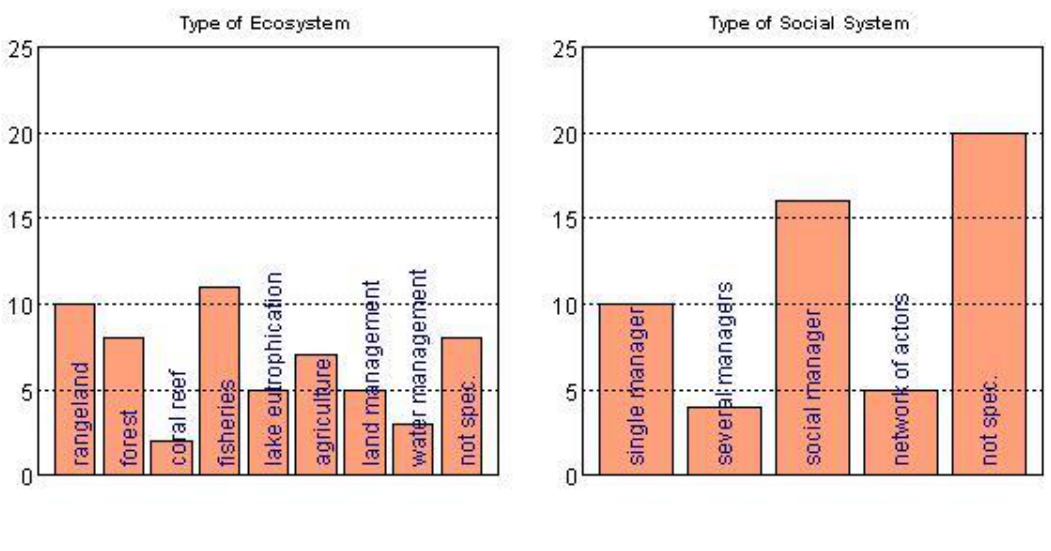
Figure A2: Ecological system/resource system (a) and social systems (b) regarded (Scale: number of papers out of all papers included in review